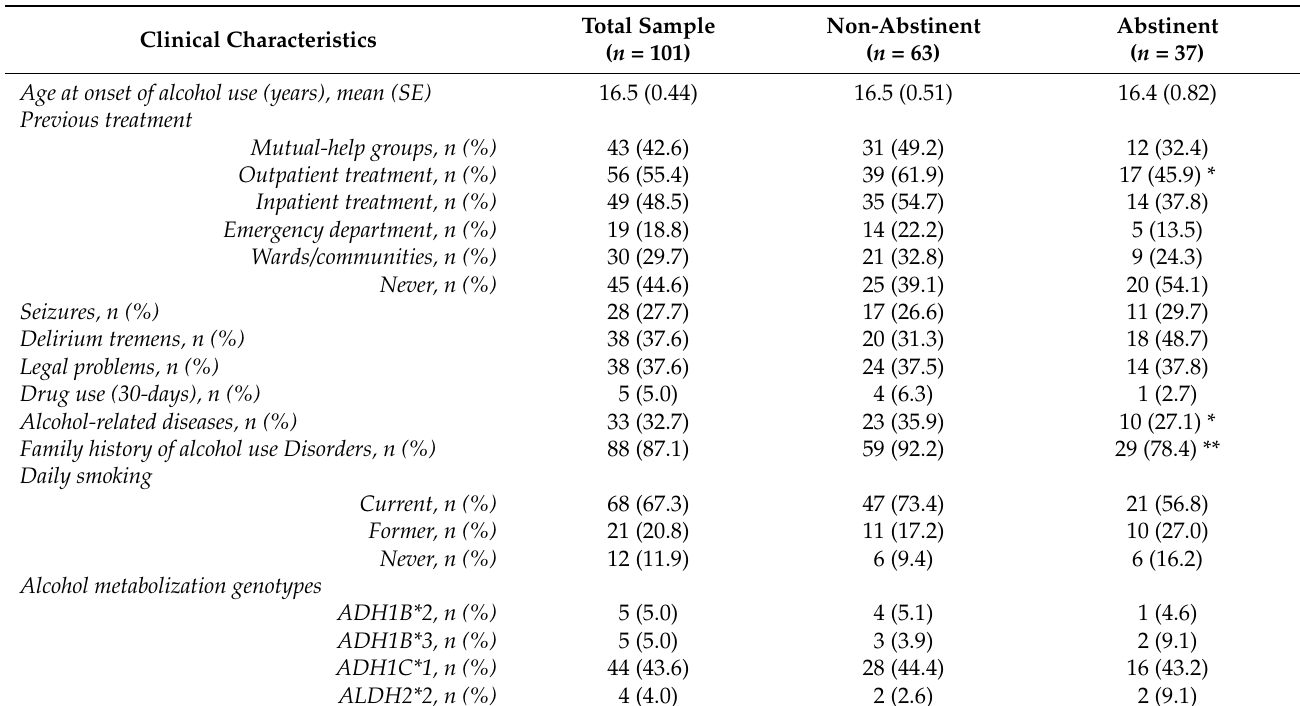
Table 3. Baseline clinical characteristics and descriptive